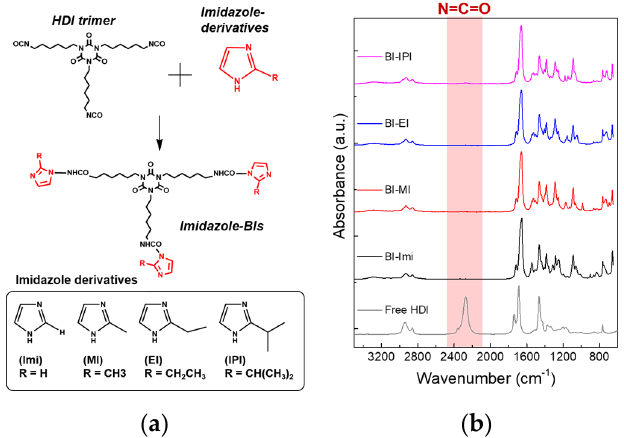
Figure 1. ( a ) Schematic of the combination of isocyanate cross-linkers with imidazole derivatives and ( b ) FT-IR absorbances of imidazole-based blocked isocyanates (imidazole-Bis) and free hexamethylene diisocyanate isocyanate